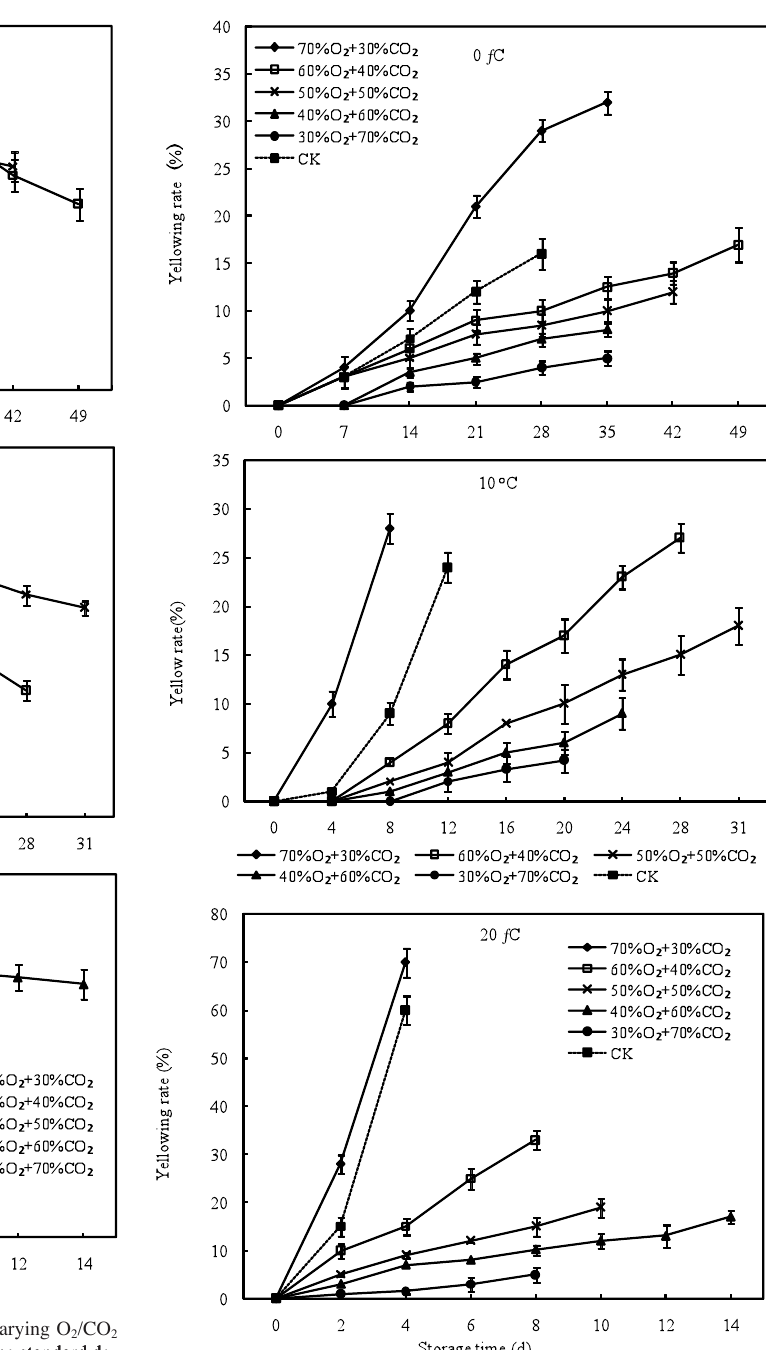
Fig. 6: Yellowing rate of broccoli heads treated with varying O 2 /CO 2 levels at different temperature. Vertical bars indicate the standard deviations for each treatment (n=5). Air treatment was used as